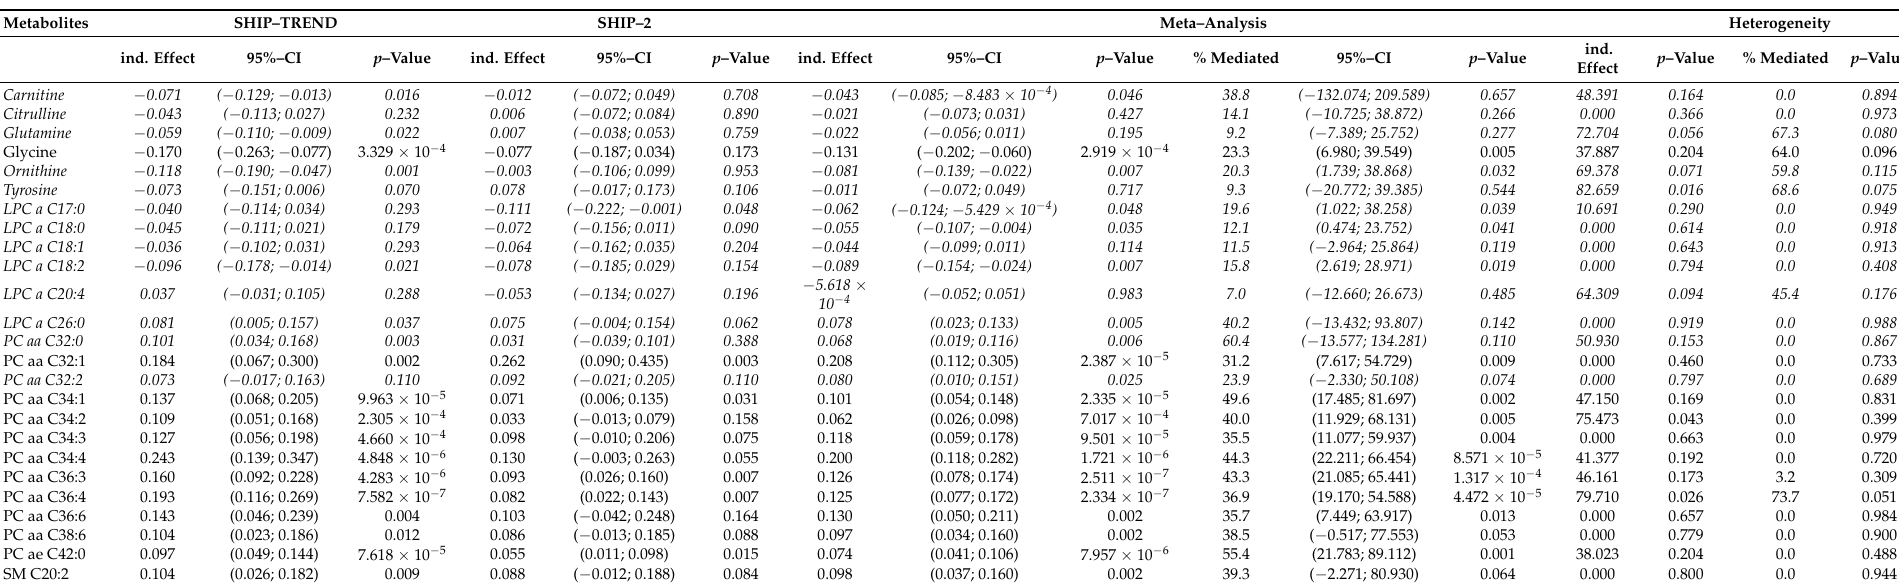
Table 4. Mediating effects of